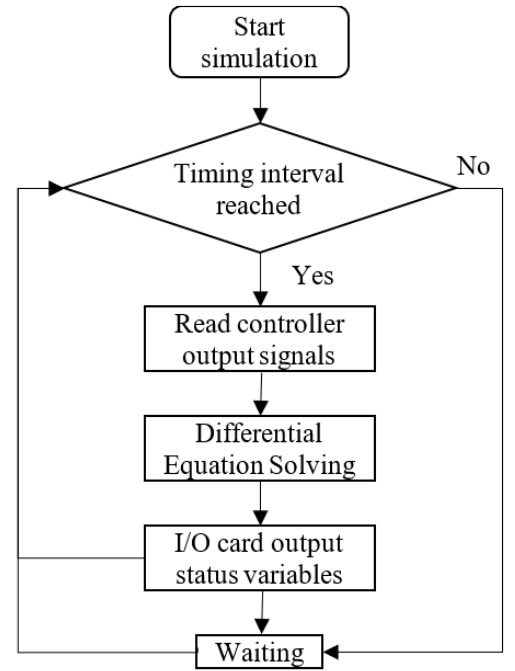
Figure 7. The flow chart of the dynamic equation resolution. The flow chart of the controller nonlinear control algorithm is shown in Figure 8.